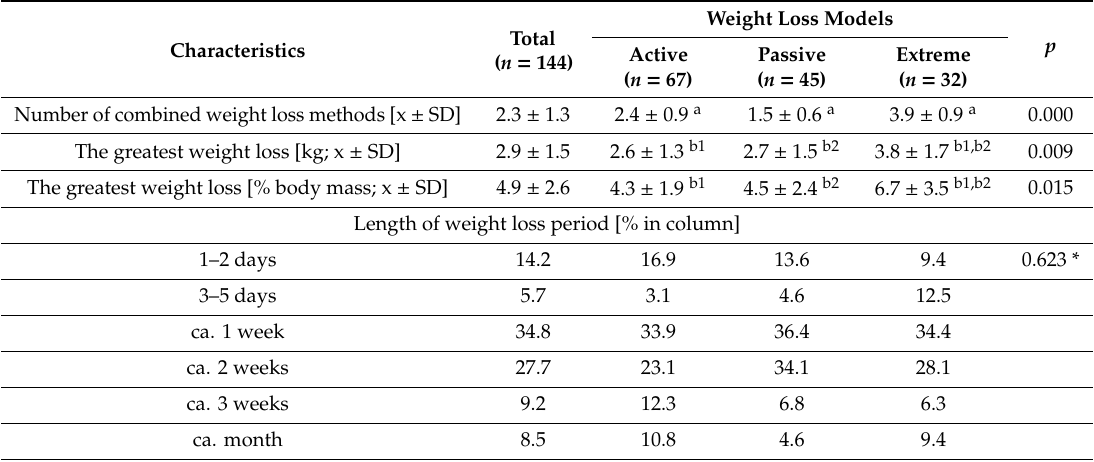
Table 2. Characteristics of weight loss process in weight loss